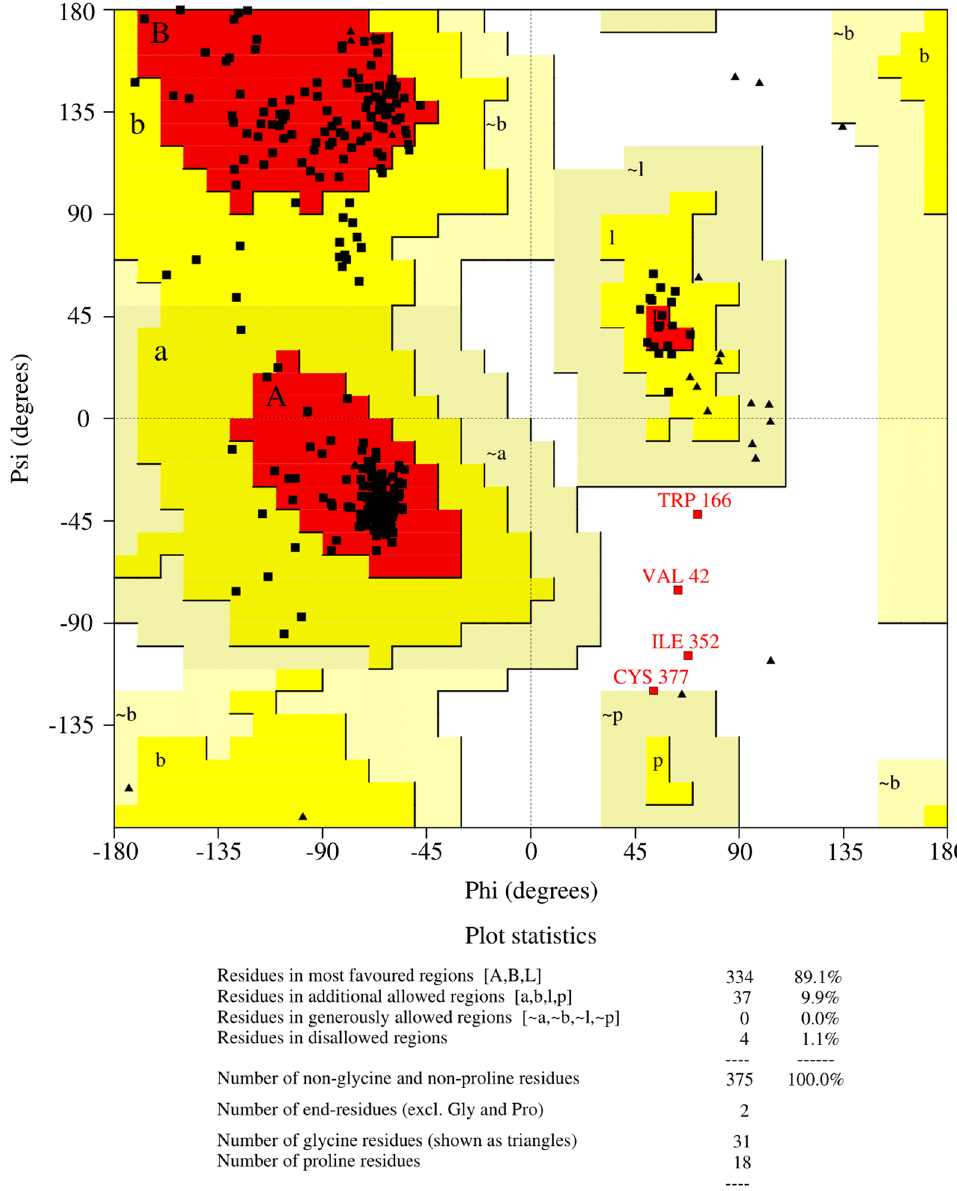
Fig. 7 Ramachandran plot obtained from